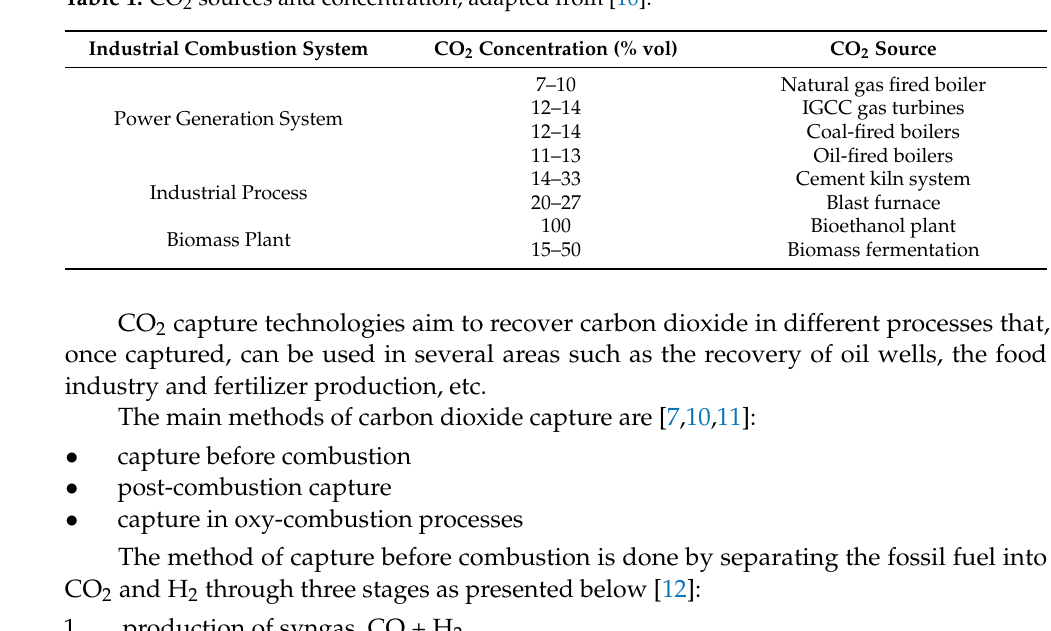
Table 1. CO 2 sources and concentration, adapted from